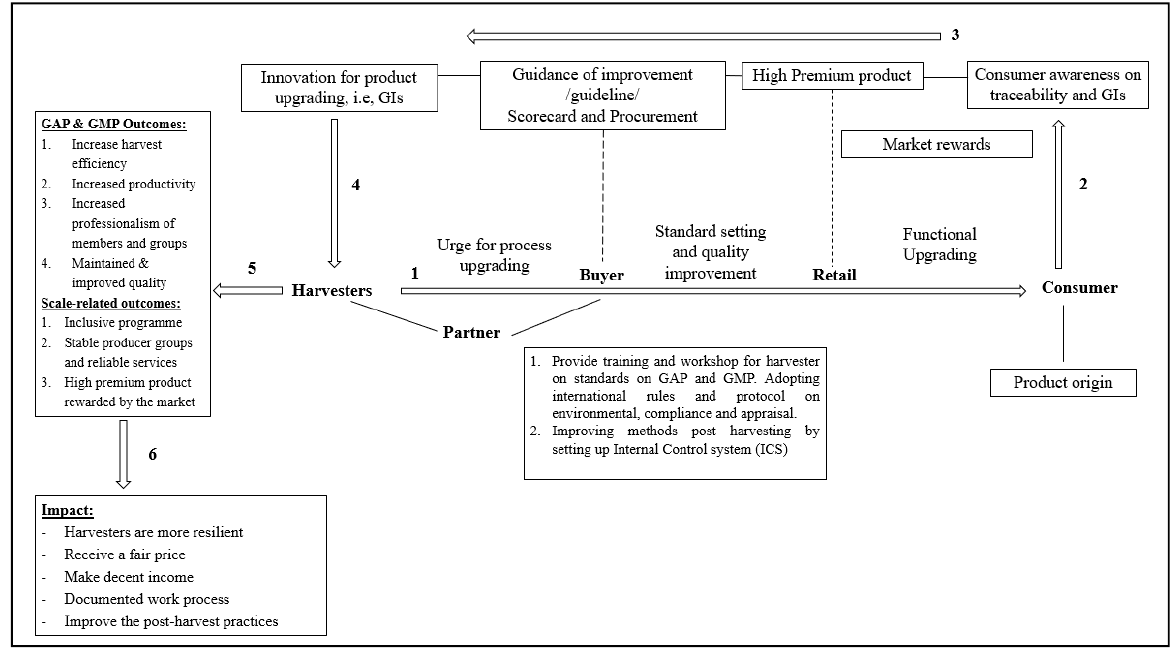
Figure 12. The GIs Koerintji cinnamon is an added value to meet buyers’